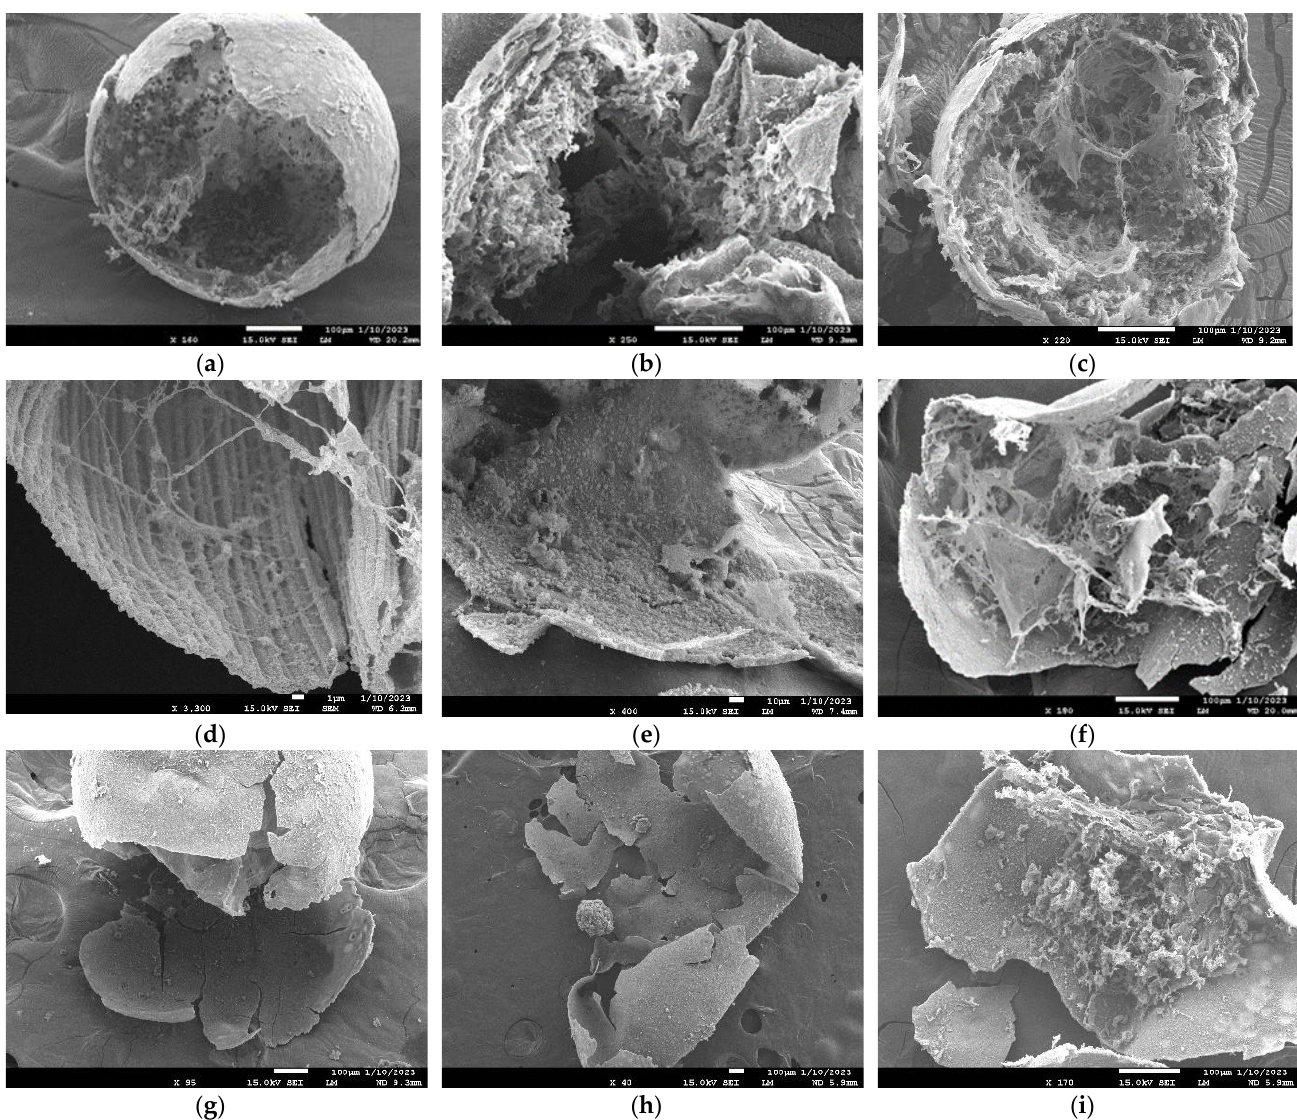
Figure 13. Scanning electron microscopy images of the 90-day encapsulation culture. ( a – c ) Chondrocyte days 30, 60, and 90; ( d – f ) bMSC days 30, 60, and 90; ( g – i ) mixed days 30, 60, and 90.